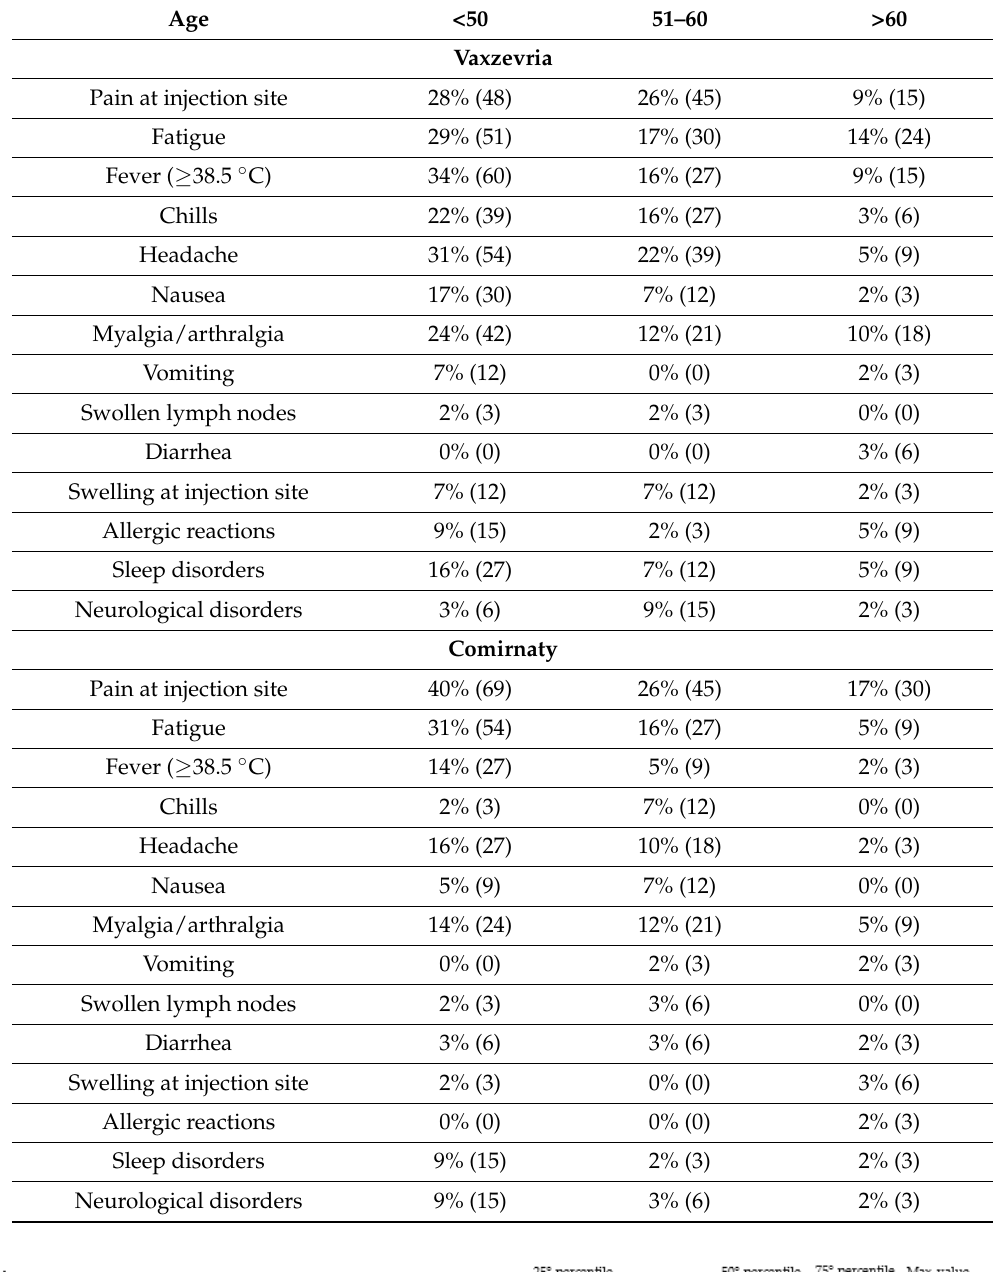
Table 5. Undesirable effects after both vaccines stratified by age.